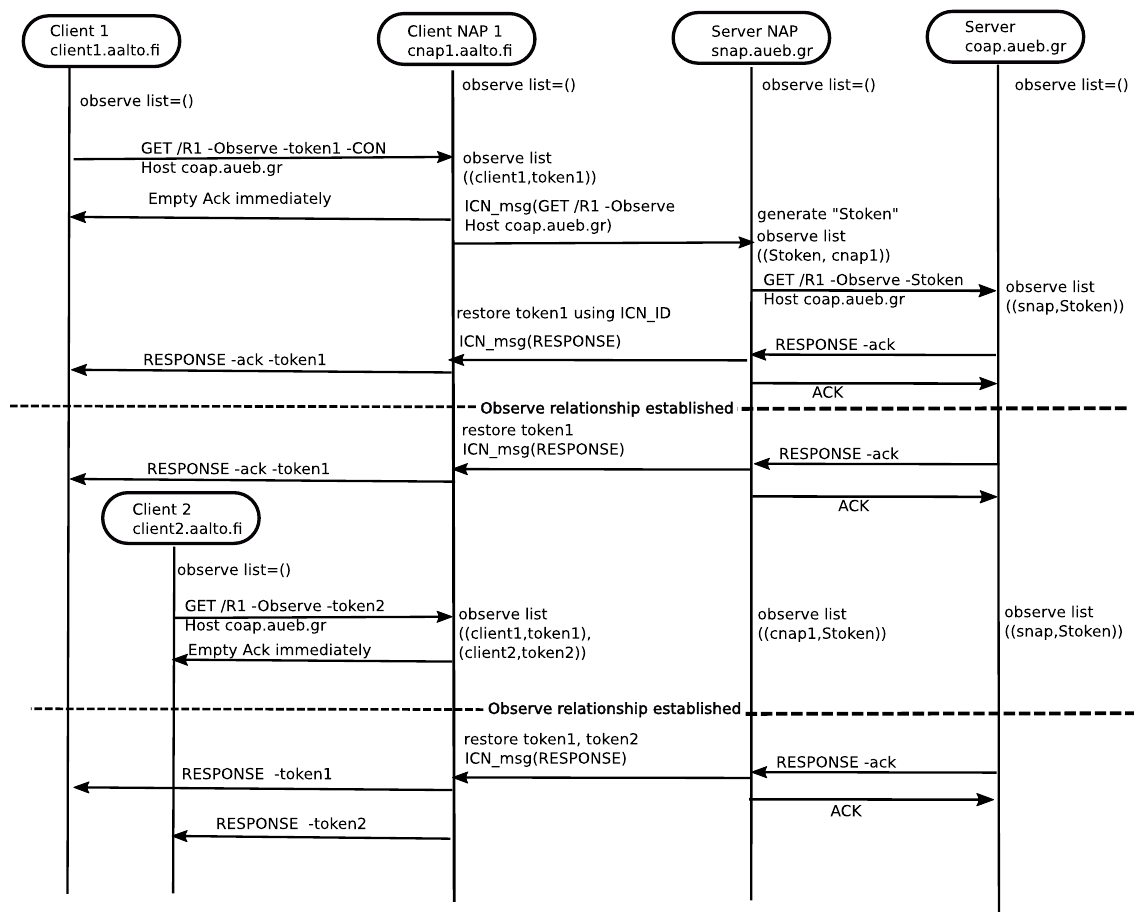
Figure 8. Message Sequence Diagram of CoAP